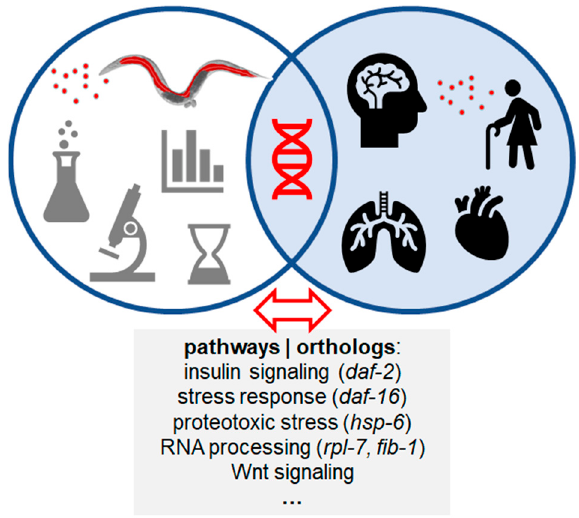
Figure 3. Characterization of gene expression (intersection, DNA double helix, red) by transcriptomics or proteomics in the model organism C. elegans (left set) and whole genome association studies (WGAS) in human cohorts (right set) exposed to nanomaterials (red dots). C. elegans orthologs of human genes play a role in aging and neurodegenerative, cardiovascular or pulmonary diseases (right set). Daf-2 , insulin-like growth factor 1; daf-16 , FOXO transcription factor; hsp-6 , heat shock protein 6; rpl-7 , ribosomal protein L7; fib-1 , fibrillarin; Wnt, Wnt signaling pathway. Briefly, 60–80% of human genes have an ortholog in the C. elegans genome, including